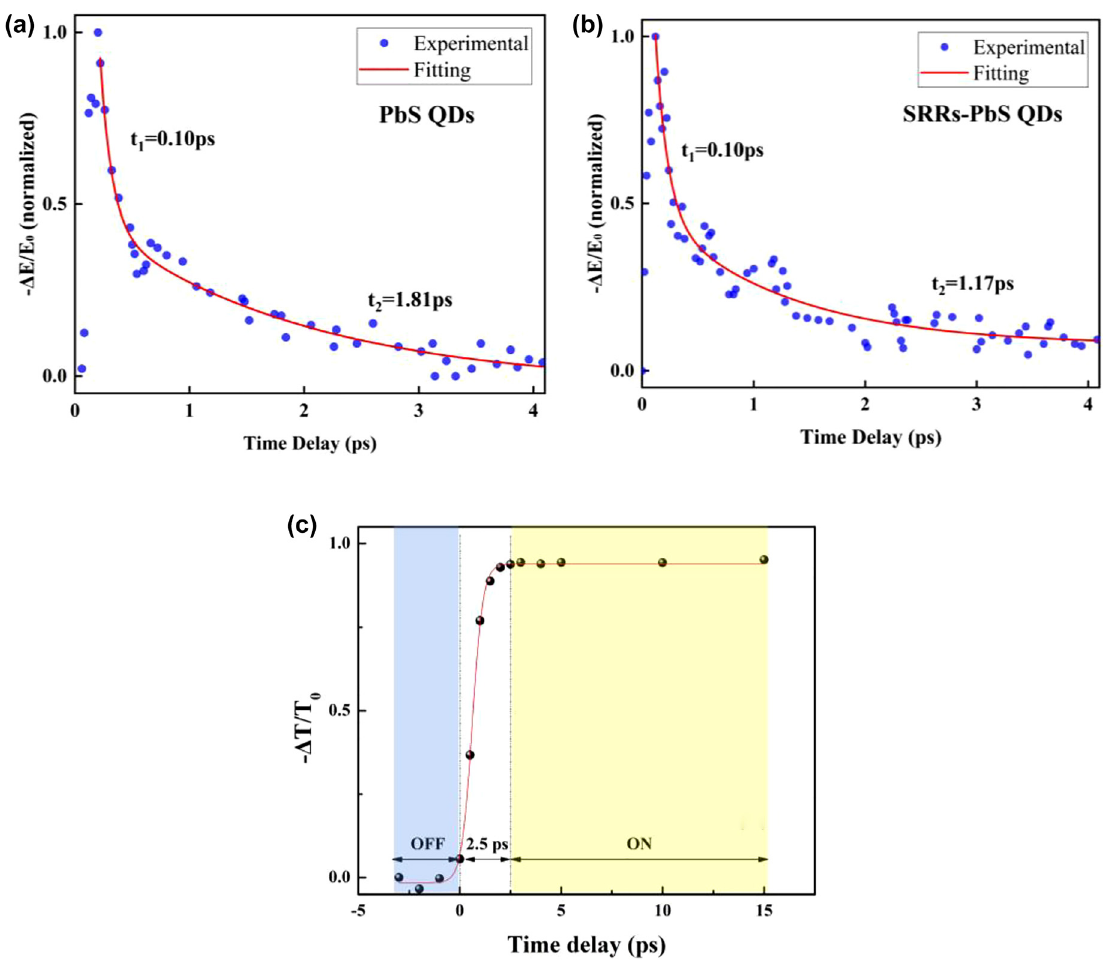
Figure 7: OPTP results and response time. (a)and(b)normalizedchargecarrierdynamicsinthePbSQDsdevicewithoutandwithSRRs,respectively,measuredusingtheOPTPsystemat